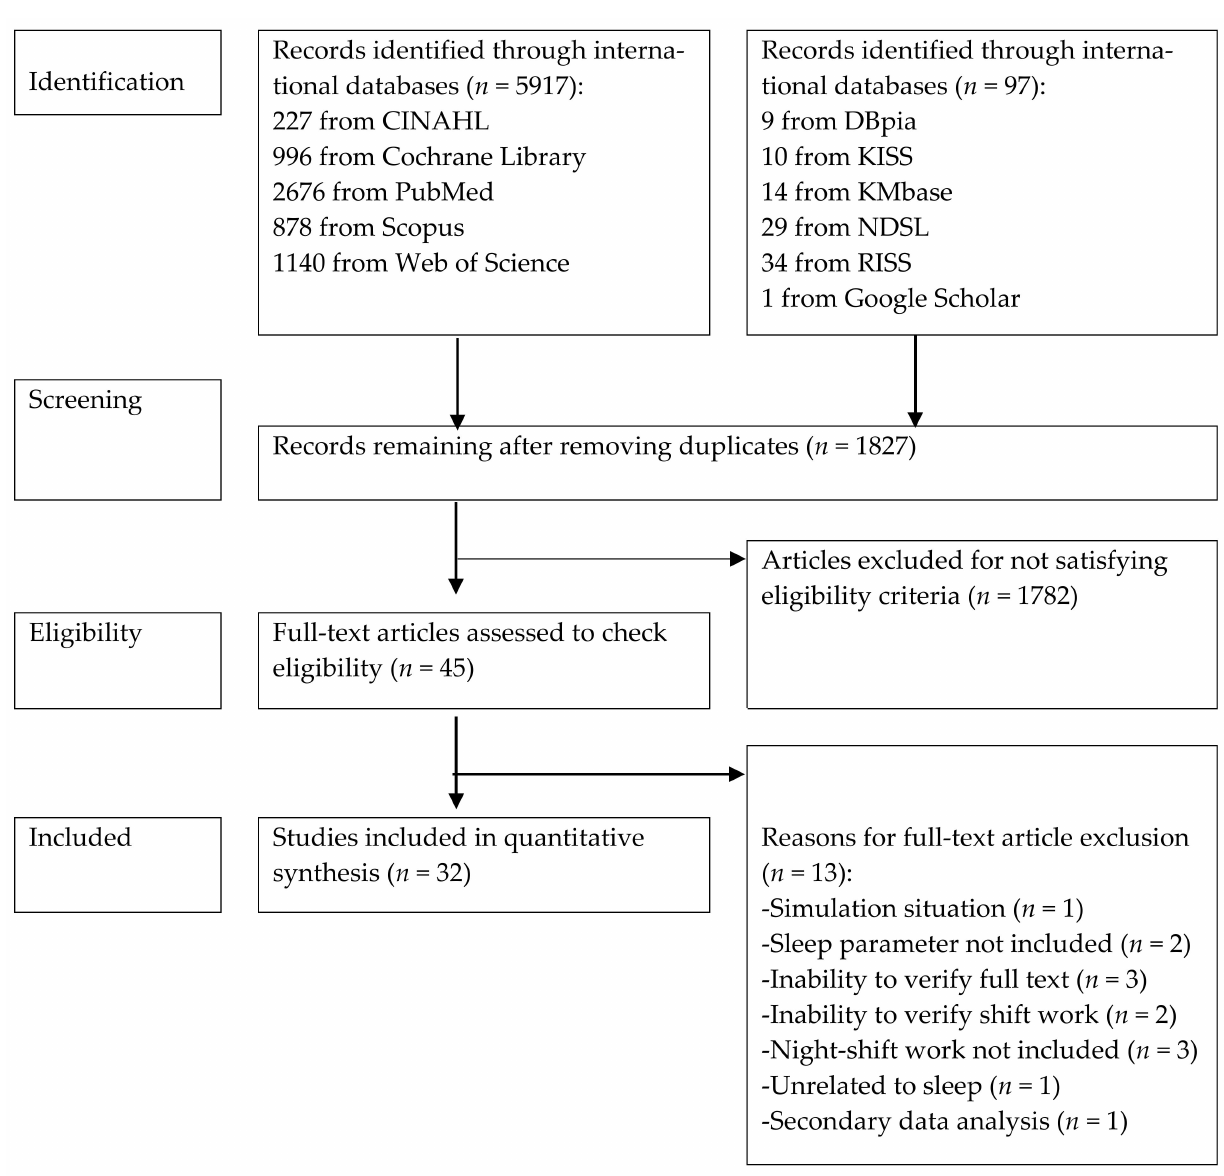
Figure 1. PRISMA flow